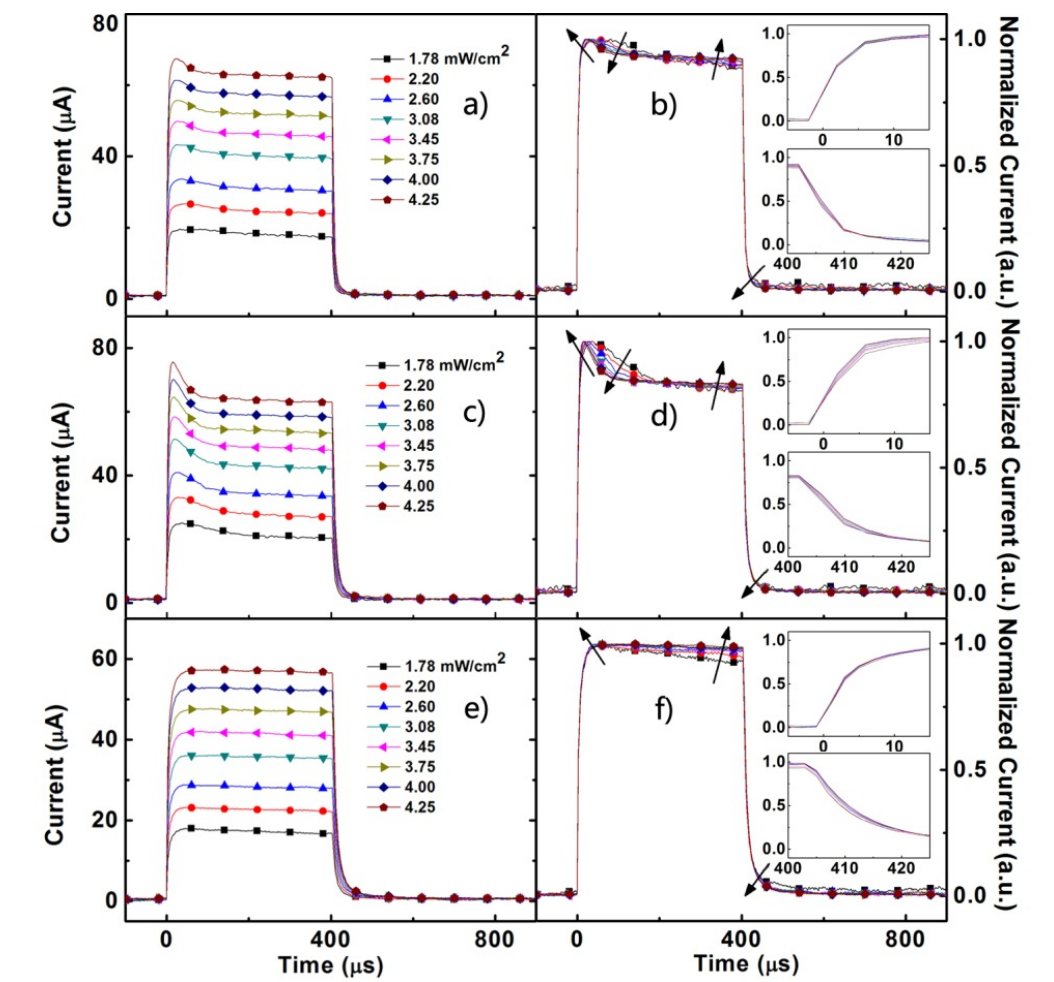
Figure 4. The normal (left) and normalized (right) transient short-circuit photocurrent of device A ( a , b ) device B ( c , d ) and device C ( e , f ) under illumination of 520 nm pulse with various intensities. The insets ( b , d , f ) show the subtle change in rise/fall